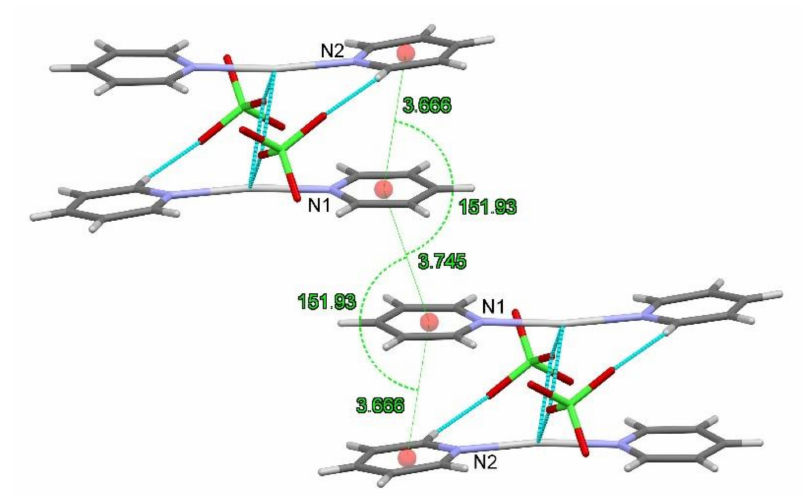
Figure 5. The π ··· π interactions formed between pyridine ligands in compound 1 . The distances of the ring centroids are indicated.